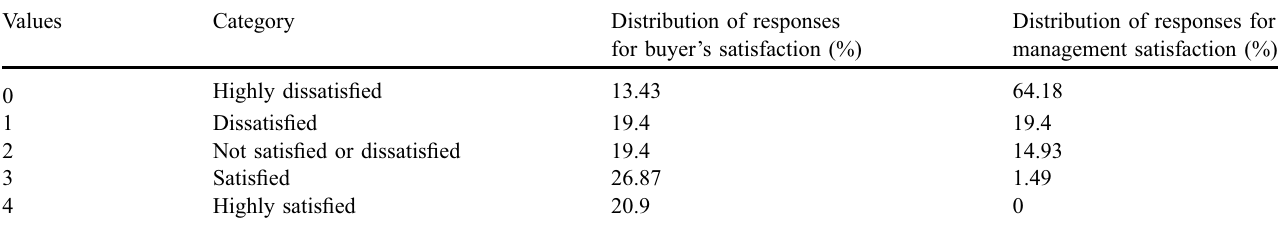
Table 7. Distribution of responses for fi sher's satisfaction towards the buyers and management.